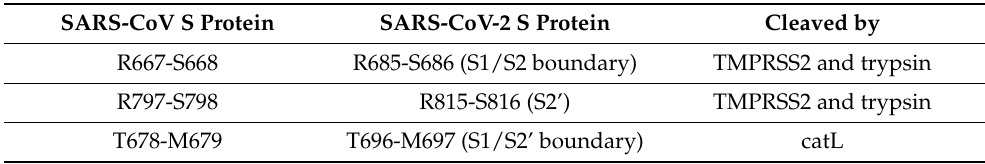
Table 3. Cleavage sites on SARS-CoV and SARS-CoV-2 S